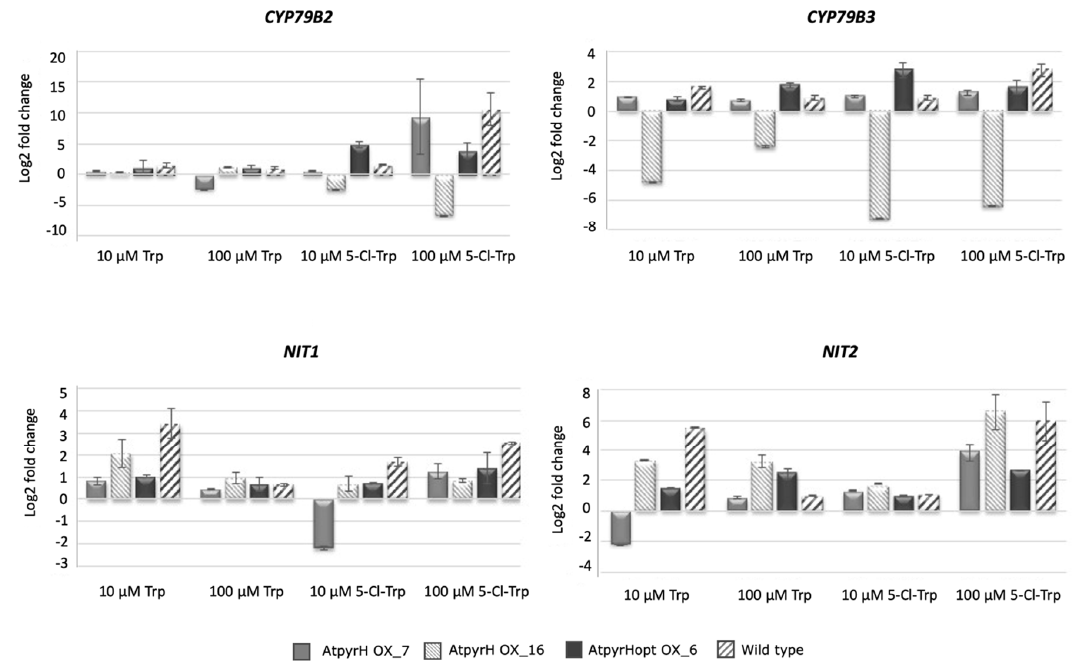
Figure 6. Expression analysis of different transgenic Arabidopsis thaliana lines harboring the 5-Cl-Trp halogenase gene pyrH and wild type after feeding of Trp and 5-Cl-Trp in different concentrations. Normalization was done to the untreated plants of the respective lines. A fold change higher than 2 in the logarithmic scale means an up-regulation of the respective gene and a fold-change under 2 a down-regulation. CYP79B2, B3 = cytochrome P450 involved in the synthesis of indole-3-acetaldoxime; NIT1, 2 = nitrilase. The individual line names are as given in the Materials and Methods Section.